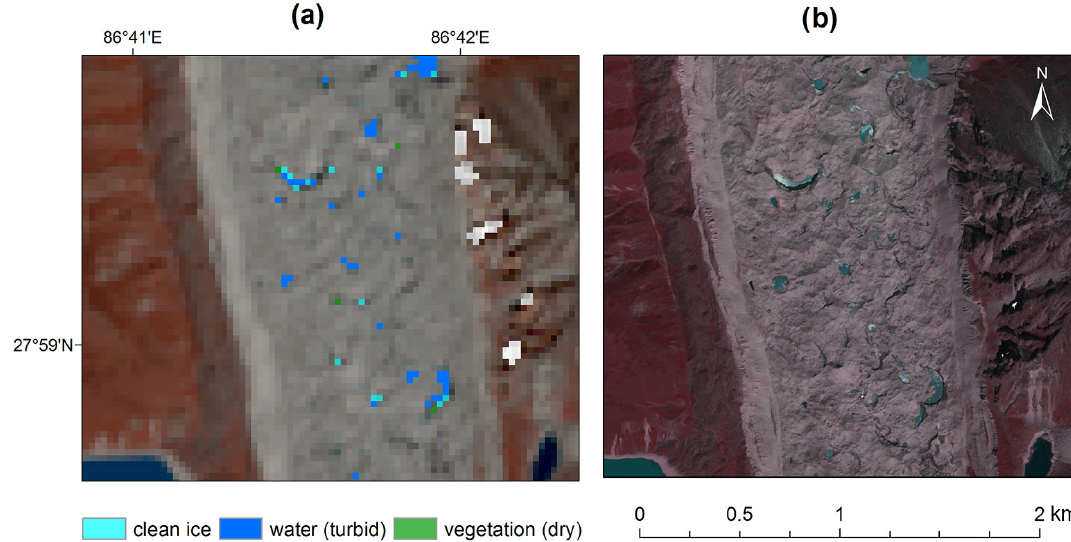
Figure 9. Ice pixels detected by the LMM at the surface of Ngozumpa Glacier in the Khumbu region. (a) Landsat 8 OLI false colour composite bands 5, 4, 3 and unmixing results for ice, water and vegetation classes only; (b) Pléiades colour composite (bands 4, 3, 2) shown for comparison, with vegetation shown as red shades. Ice cliffs display the typical crescent moon shape. White pixels in panel (a) correspond to NoData in areas of topographic shadows, resulting from the topographic correction routine. Table 5. Composition of the seven debris-covered tongues in the Khumbu region, expressed as percent coverage of each material with respect to the debris-covered zones of each glacier. Glacier Clean ice (%) Water turbid (%) Debris dark (%) Debris light (%) Cloud (%) Vegetation dry (%)